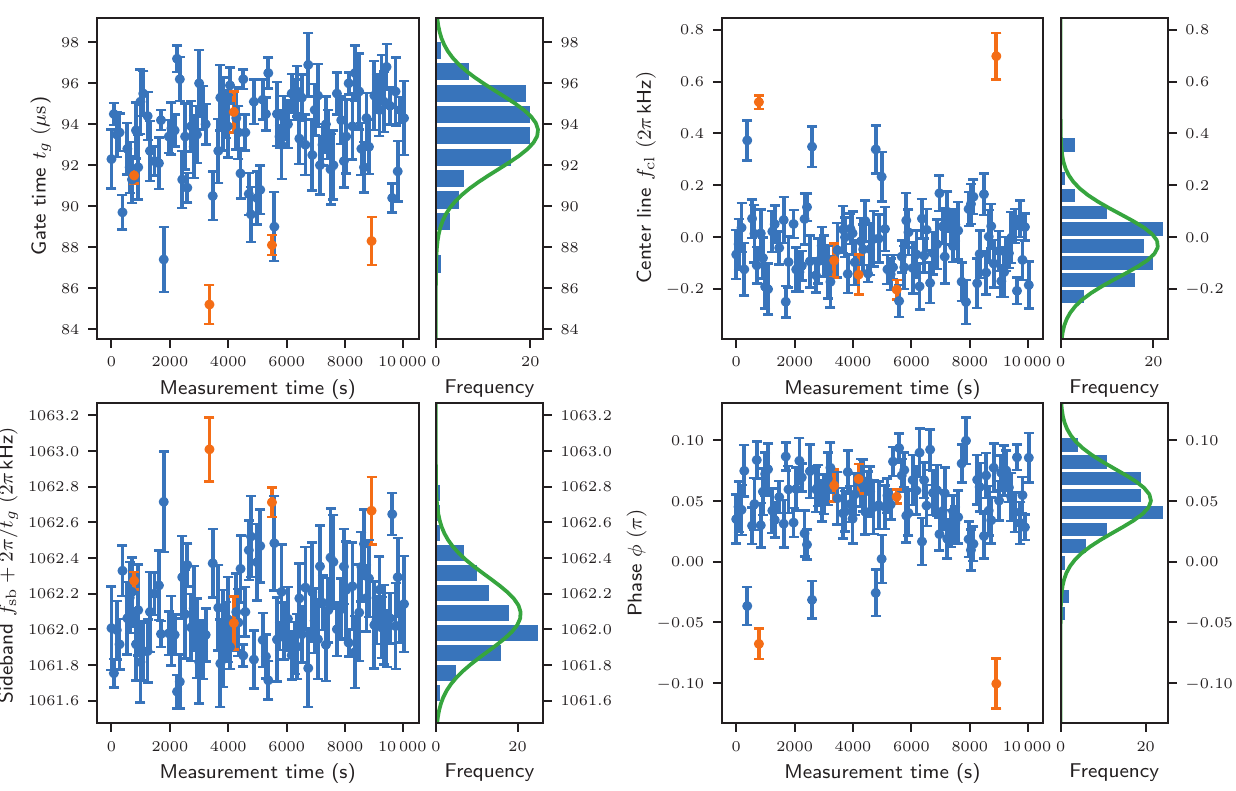
FIG. 10. Final parameter estimates and uncertainties for 103 iterations of tuning up the Mølmer-Sørensen gate versus time elapsed. The orange points are runs rejected by the confirmation criterion described in Sec. IV E, corresponding to 5(2)% of all runs. Removing the rejected points reduces the standard deviation of the distributions of final parameter estimates between 13%–20%. Green curves show a Gaussian distribution fitted to a histogram the distribution of final parameter